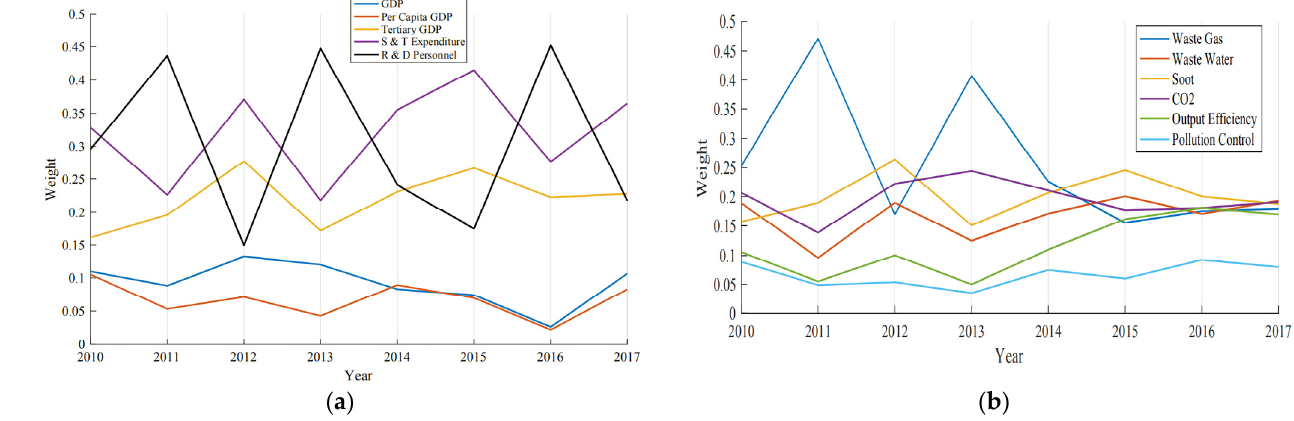
Figure 5. Trends in weight changes of each secondary indicator measured by the entropy method over the years. ( a ) land use transition measured from the economic dimension; ( b ) land use transition measured from the green development dimension.